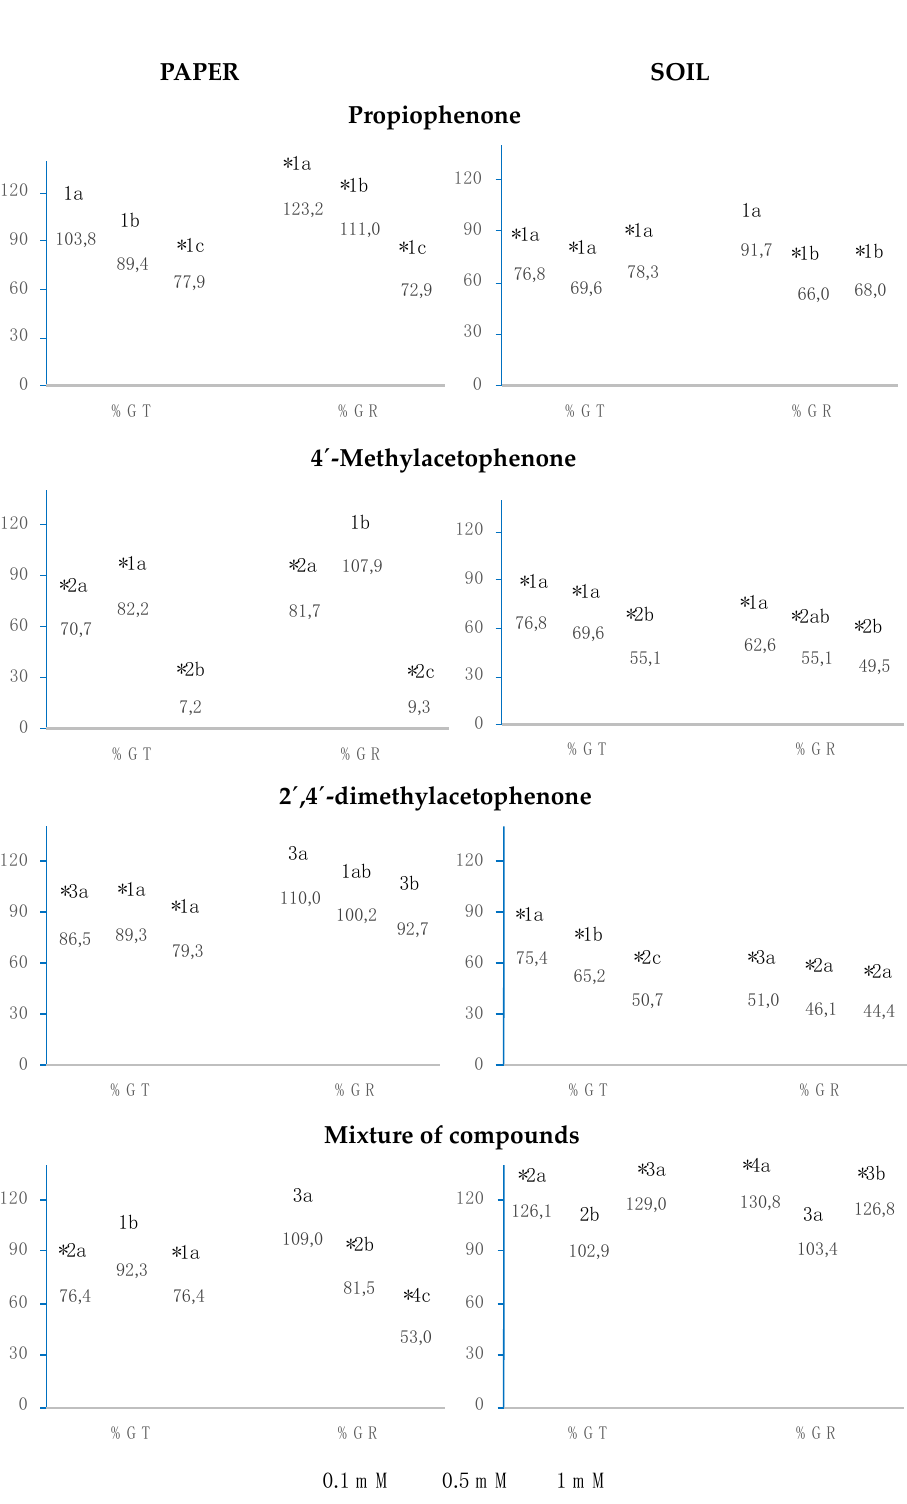
Figure 4. The effect of different concentrations of propiophenone, 4 ′ -methylacetophenone, 2 ′ ,4 ′ -dimethylacetophenone, and the mixture of the three compounds on the total germination (%GT) and germination rate (%GR) of Allium cepa , expressed as the percentage relative to the control. Four replicates of each treatment were performed (n = 4 × 50 = 200 seeds in total for each solution). * Significantly different from the controls; 1, 2, 3, and 4: differences numbers indicate significant differences between treatments of the same index and for each concentration. The a, b, c: differences in small letters indicate significant differences between concentrations of the same index and for each treatment. p < 0.05 (Mann – Whitney U test).